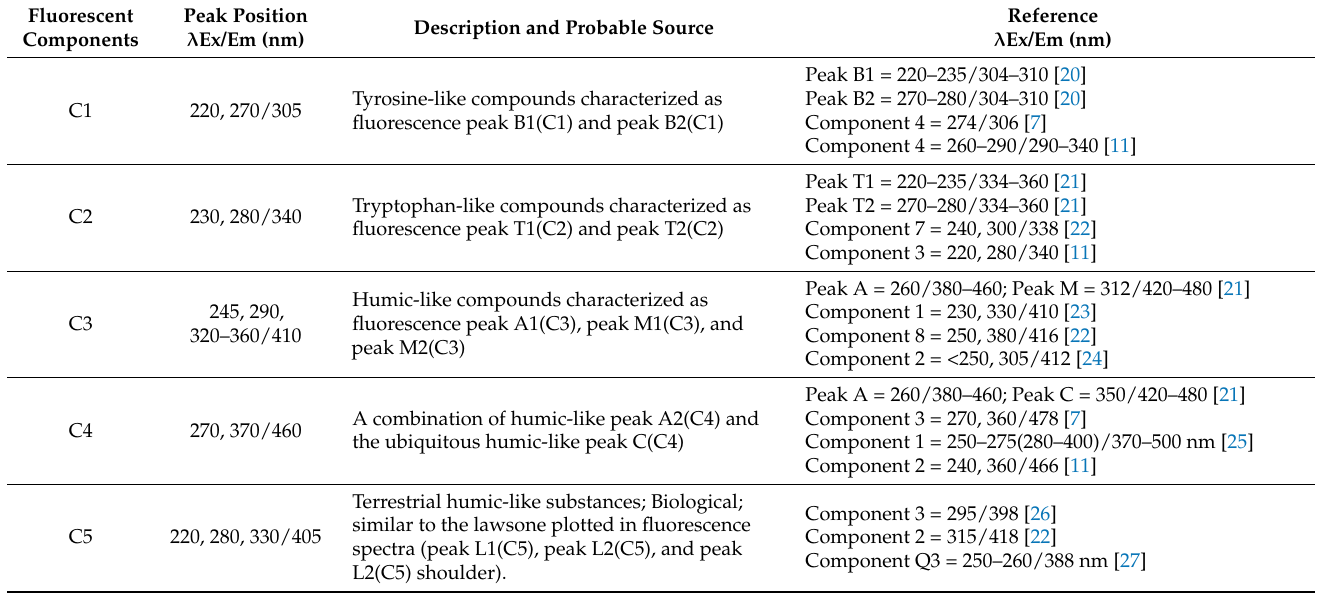
Table 1. DOM components’ spectral characteristics were identified by PARAFAC modeling for the EEM data set collected at different composting times. (Note: Naming rules for the fluorescence peaks in this study were: 1 (cid:13) peak X corresponds to the peak in reference. 2 (cid:13) Letter C and a number in brackets represent the fluorescence molecular number in this